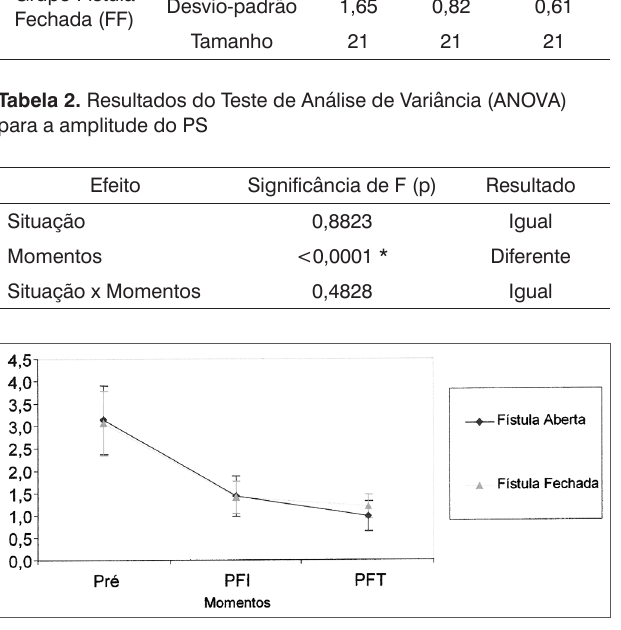
Tabela 4. Resultados do Teste de Análise de Variância (ANOVA) para a amplitude do